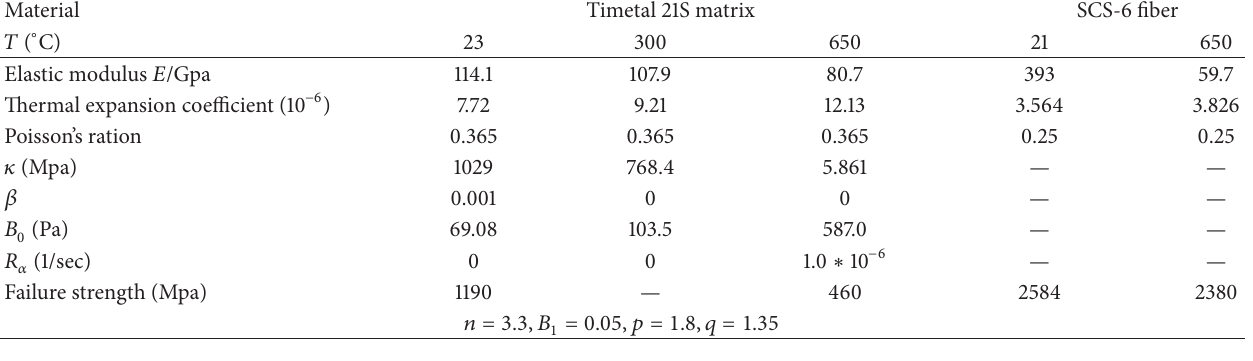
Table 1: Material constant and viscoplastic parameters of Timetal 21S matrix.